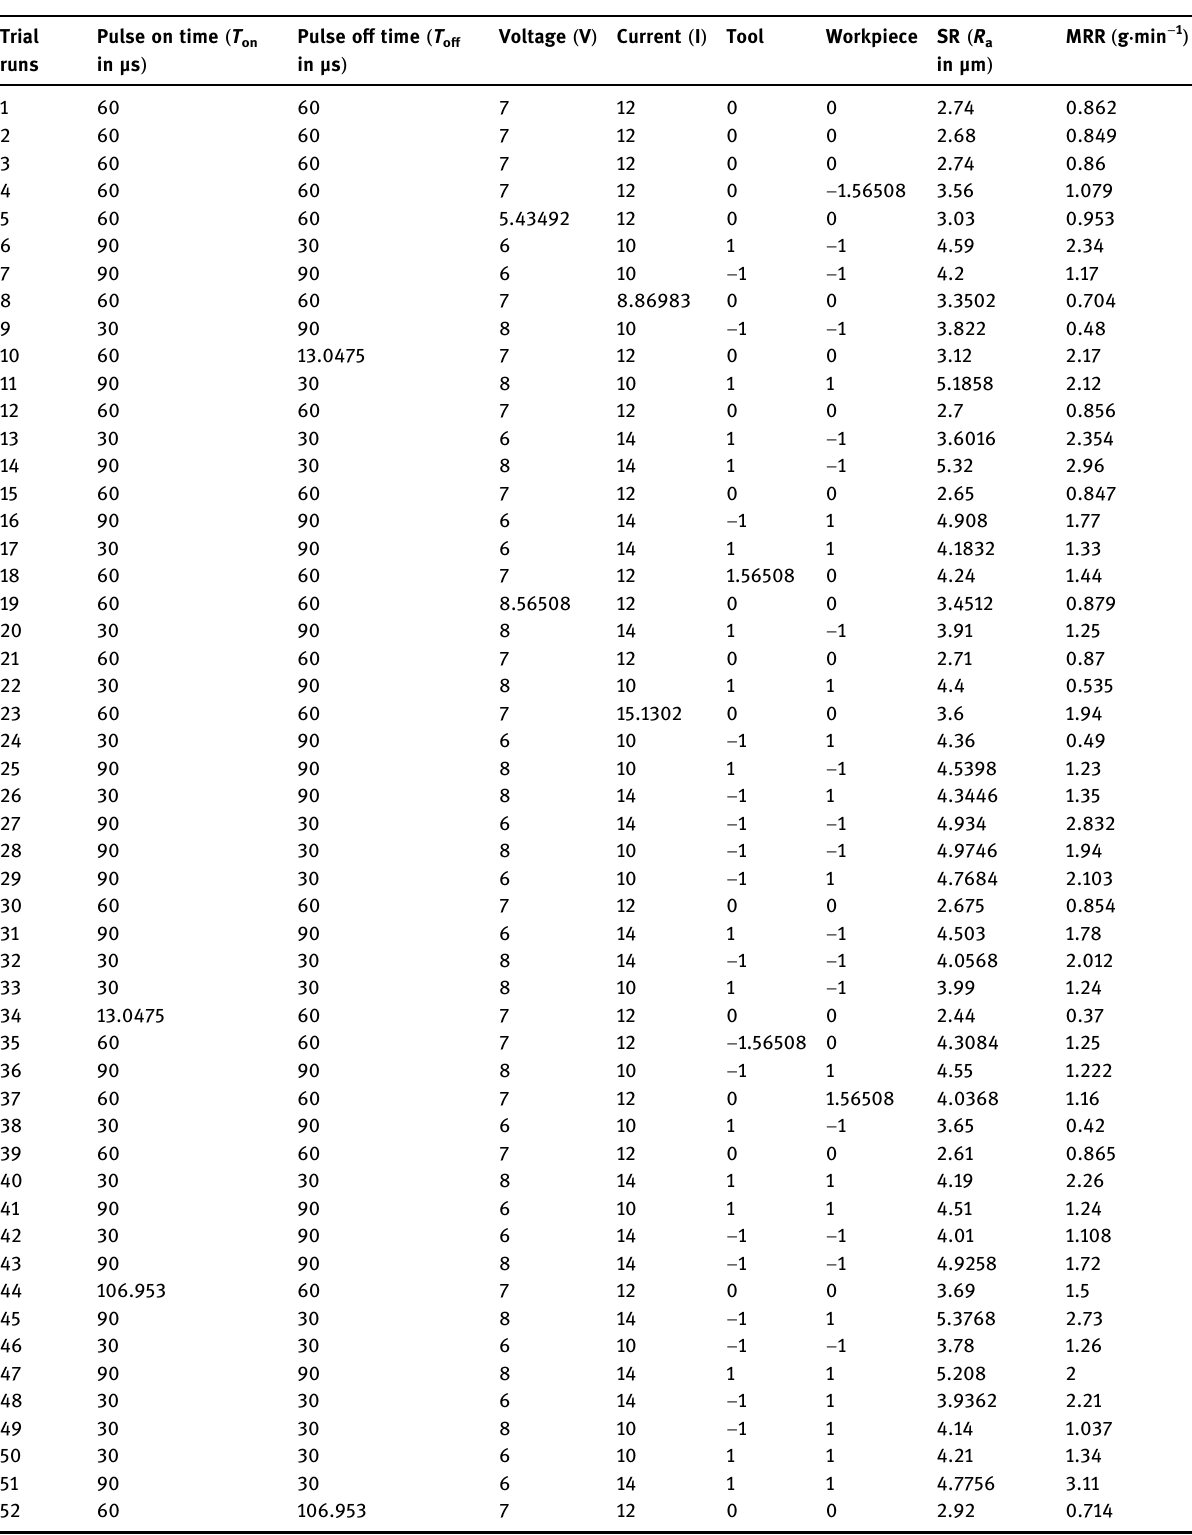
Table 3: Design matrix and trial results for MRR and